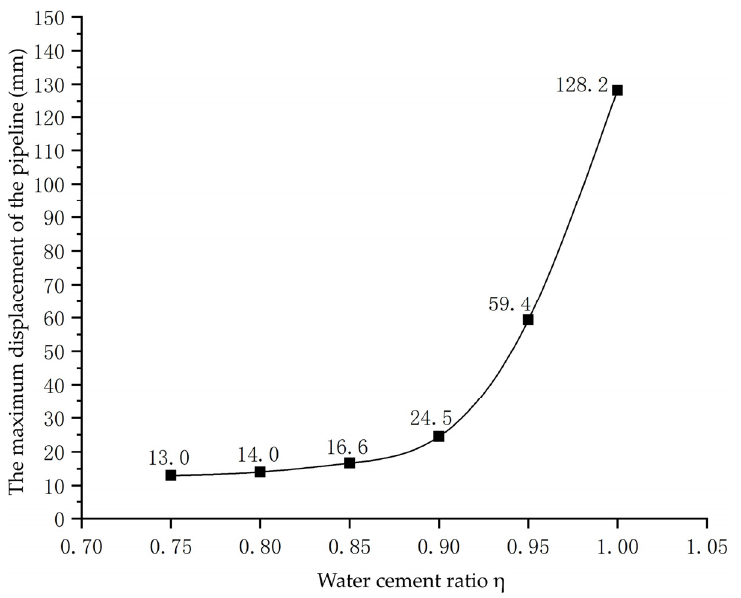
Figure 24. Relationship between the maximum displacement of pipeline and water–cement ratio η .